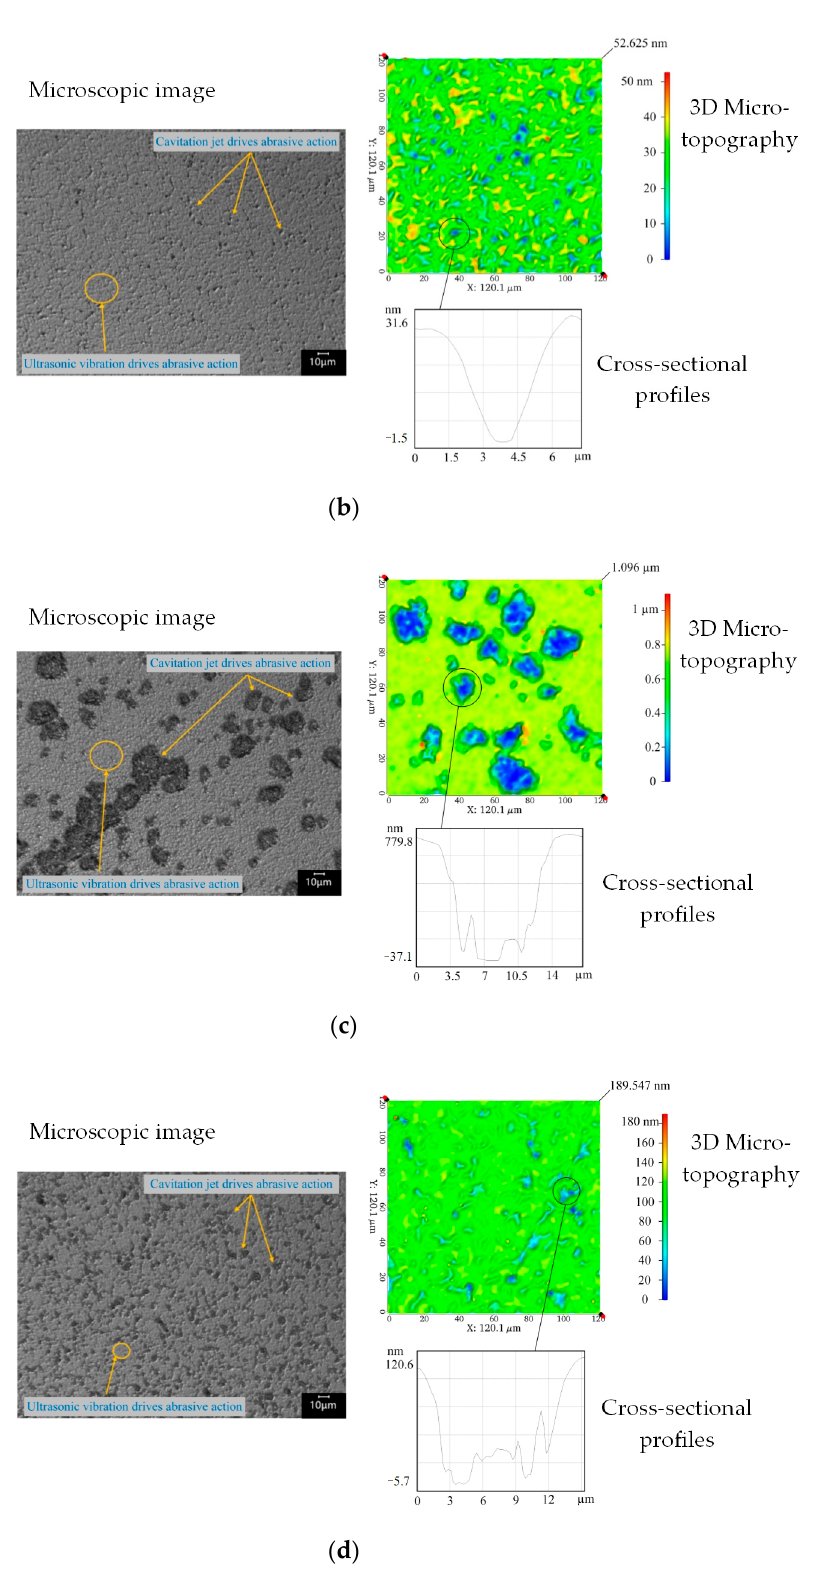
Figure 12. Comparison of machining morphology under different abrasive particle size. ( a ) Abrasive particle size was 0.5 μ m. ( b ) Abrasive particle size was 2.5 μ m. ( c ) Abrasive particle size was 10 μ m. ( d ) Abrasive particle size was 20 μ m.